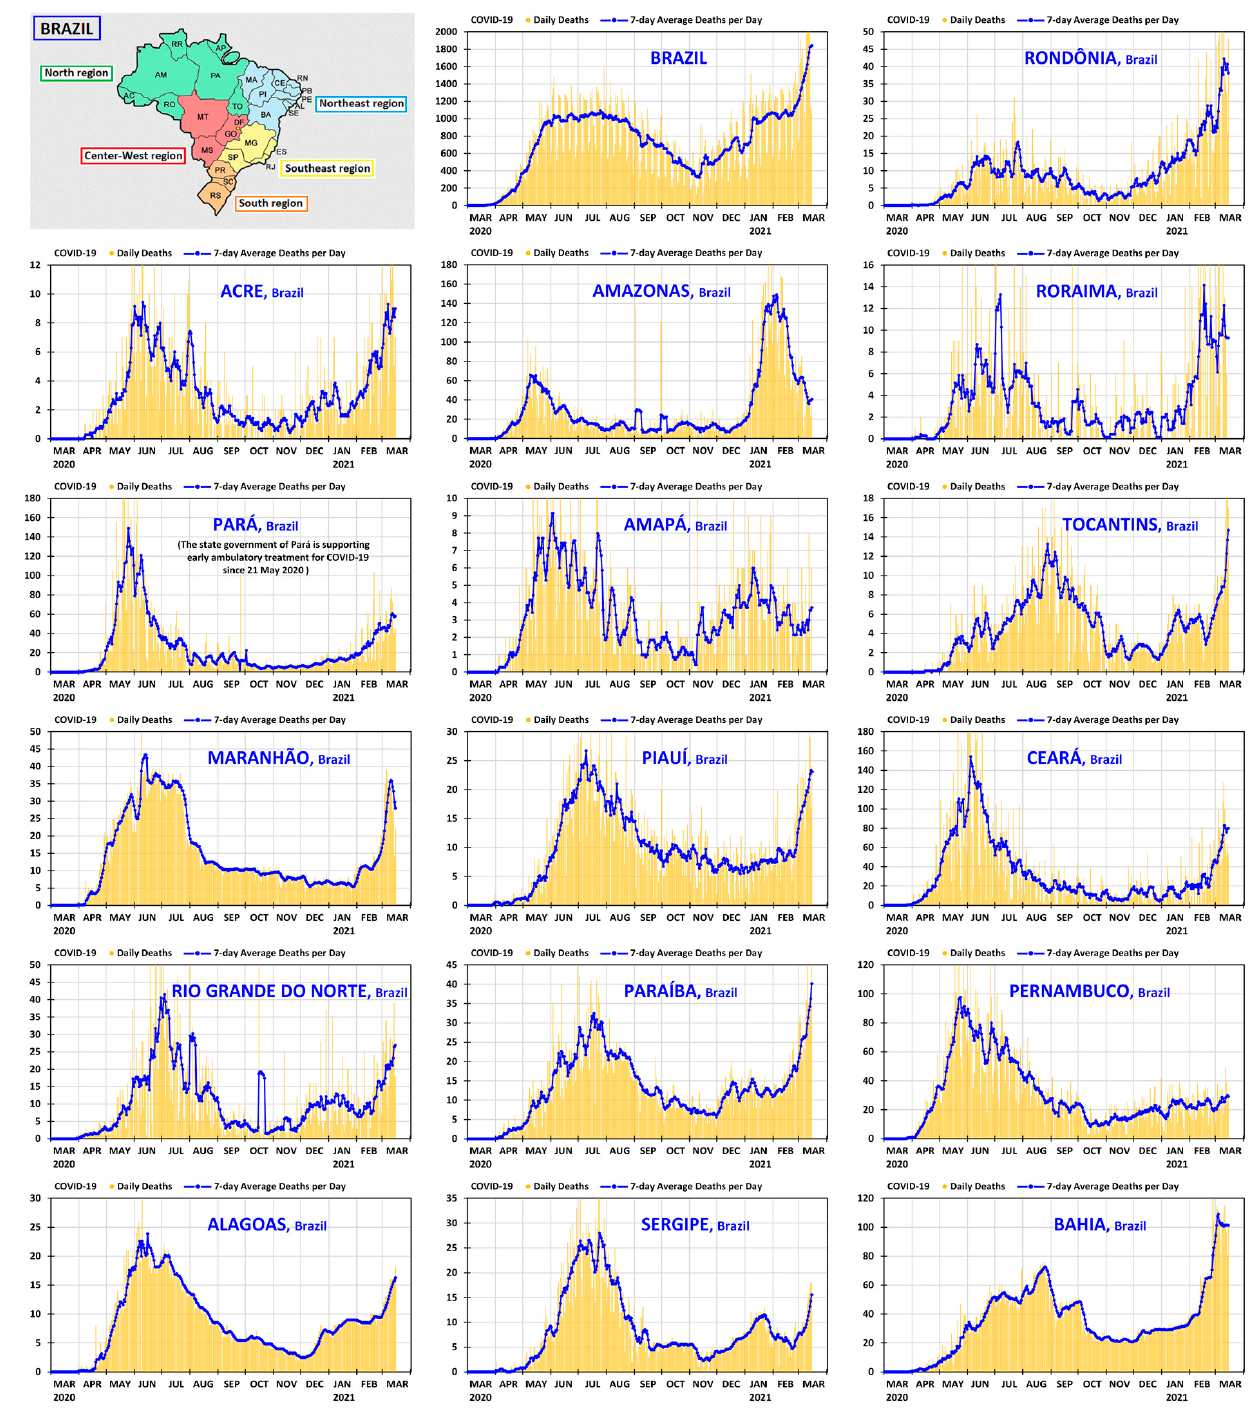
Figure 5. Daily deaths and 7-day average deaths per day of COVID-19 in Brazil and in the states of the North and Northeast regions of Brazil from 1 March 2020 to 15 March